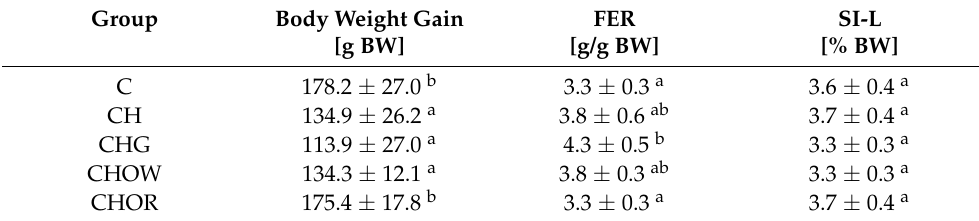
Table 3. Influence of lyophilized garlic, white onion, and red onion addition on performance (body weight gain, FER, and somatic index of liver (SI-L)) in rats fed the control and the cholesterol- containing (1% of cholesterol) diet during the 28 day